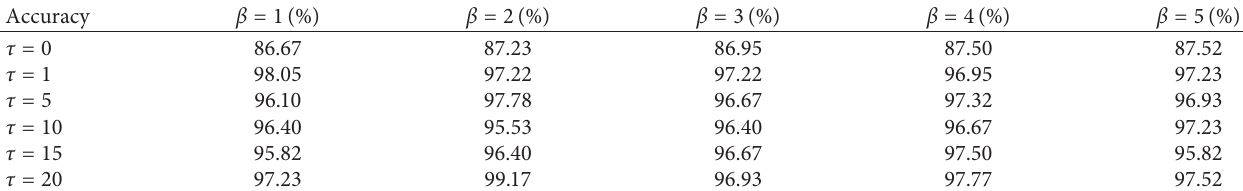
Table 5: Classification accuracy for parameters combinations in multiple working conditions. Accuracy